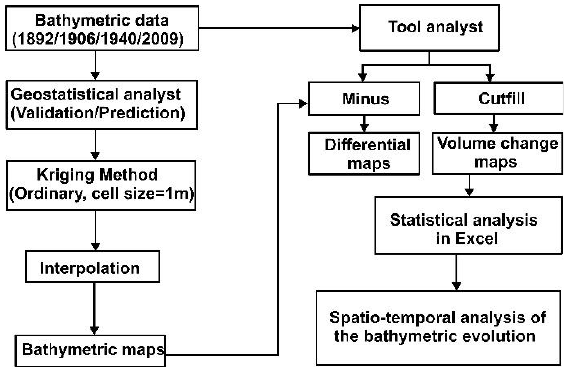
Figure 2. Flowchart of bathymetric study of Safi